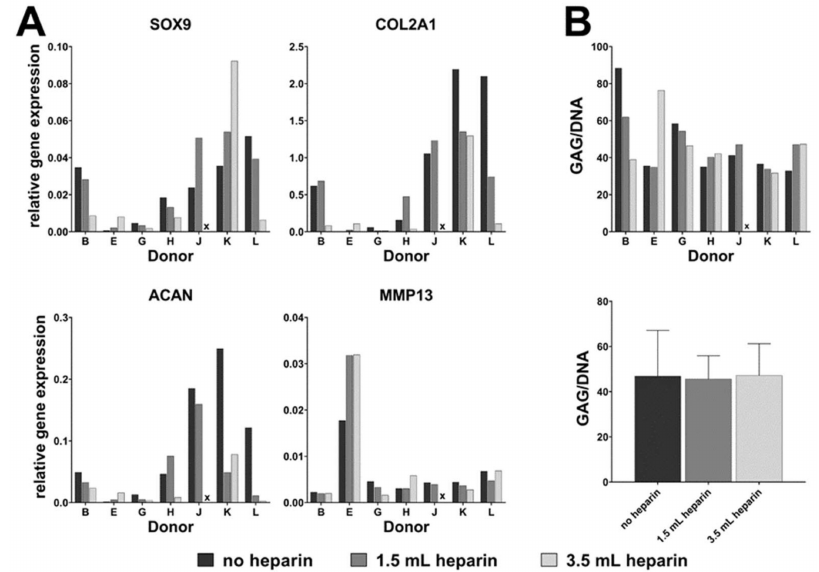
Figure 7. Chondrogenesis in vitro. ( A ) qRT-PCR analyses of chondrogenic marker genes (2 − ∆ Ct ) at day 28. ( B ) Glycosaminoglycan(GAG) / DNA ratio at day 28 (upper panel) and mean values of the GAG / DNA-ratios (lower panel) for these seven donors were comparable in all three conditions (lower